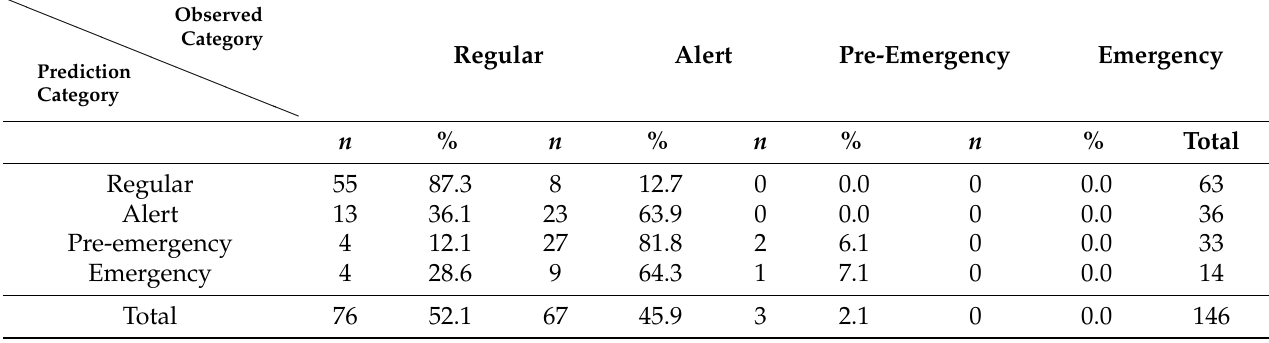
Table 9. Categorization of observed and predicted PM10 levels according to air quality regulations during the CEM period for the Pudahuel monitoring station, in Santiago, Chile, during